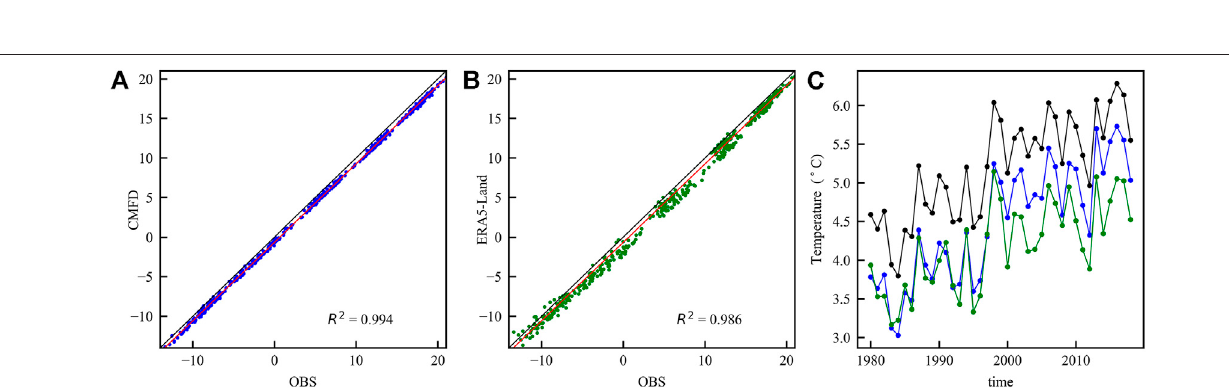
FIGURE 6| (A – C) Spatial distribution of mean monthly temperature in the Qilian Mountains for the period 1980 – 2018, from station observations (OBS), CMFD (D) and ERA5-Land (E) .